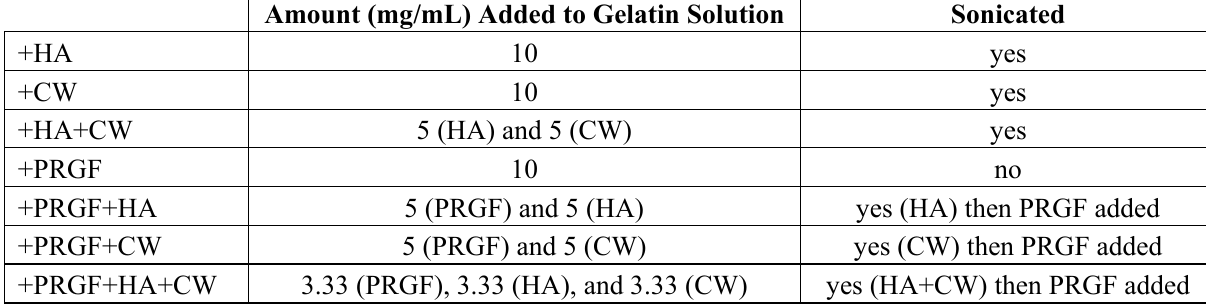
Table 5. Scaffold Components and Fabrication